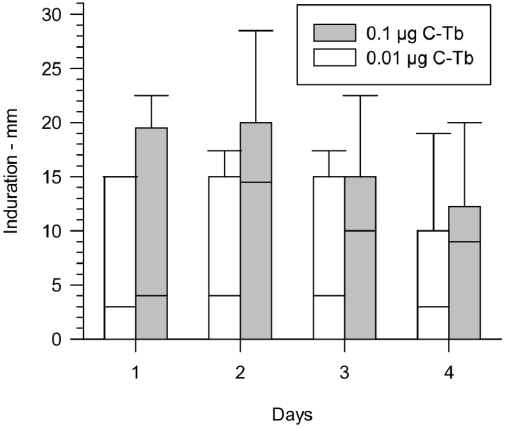
Figure 3. Time course of the induration response to preserved C-Tb in patients with active TB. The median induration response (line within boxes) is shown for the first 4 days after injection of TB patients with 0.01 m g (white; N=11) or 0.1 m g C-Tb (grey; N=24) in dose-finding trial. The boundaries of boxes are 25 th and 75 th percentiles. Error bar indicate 90 th percentile.